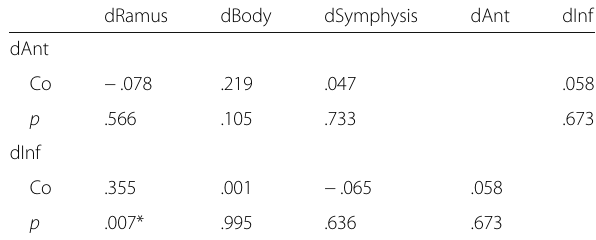
Table 5 Pearson ’ s correlation coefficiency in retroganthic